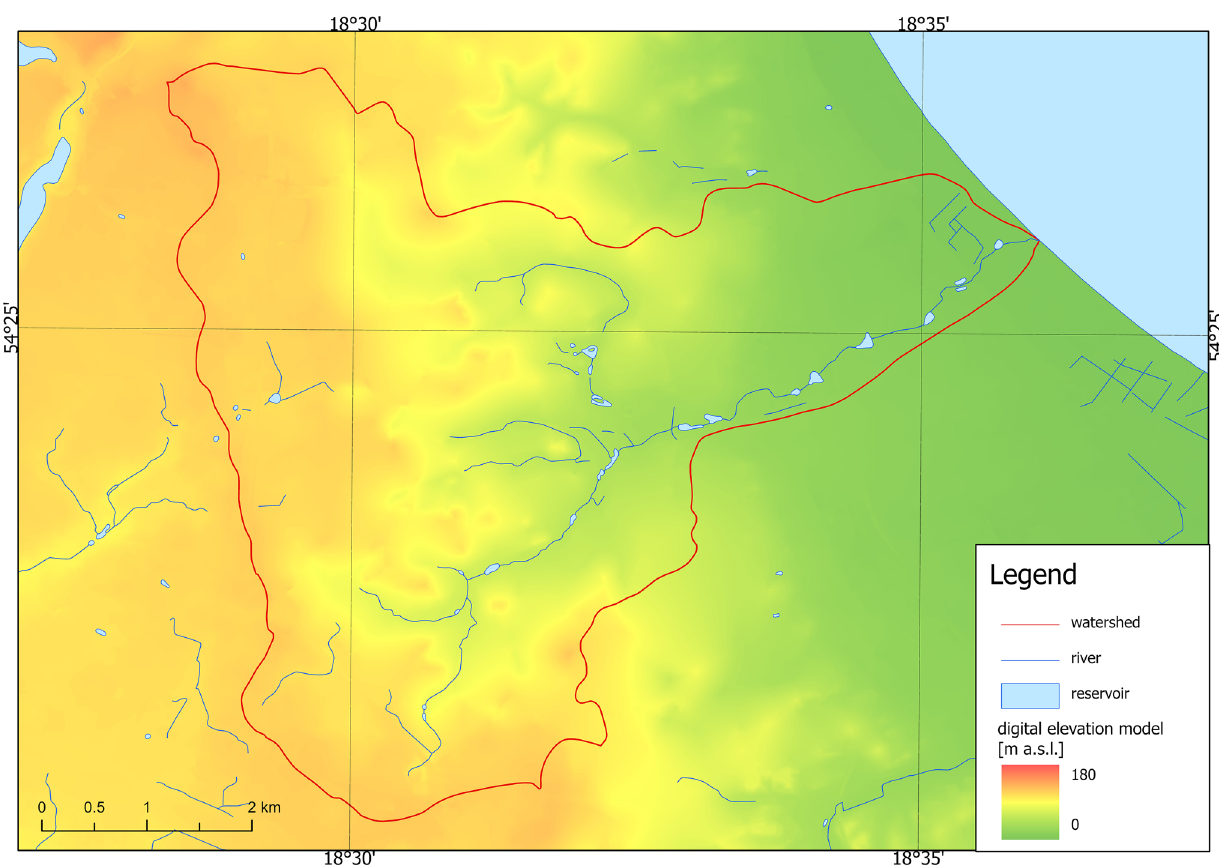
Fig. 1 Numerical terrain model of the Potok Oliwski